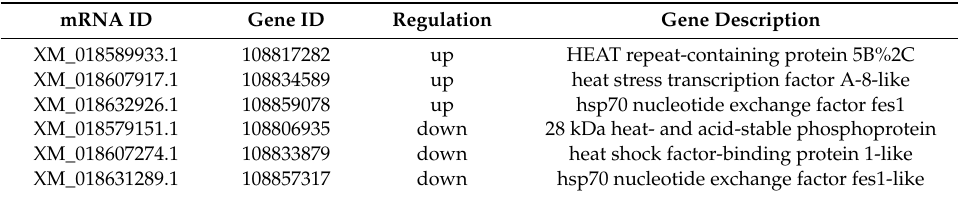
Table 1. Selected DE mRNAs related to HS in QHC06 vs. QHC00.